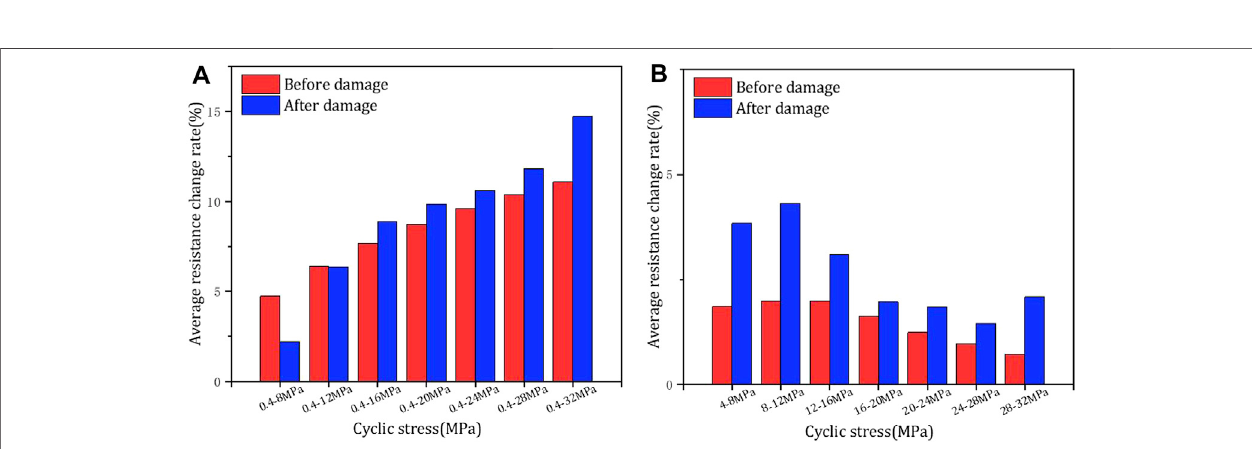
FIGURE 10 | Comparison of average resistance change rates: (A) under free cyclic loading at different stress levels before and after damage; (B) under load cyclic loading at different stress levels before and after damage.